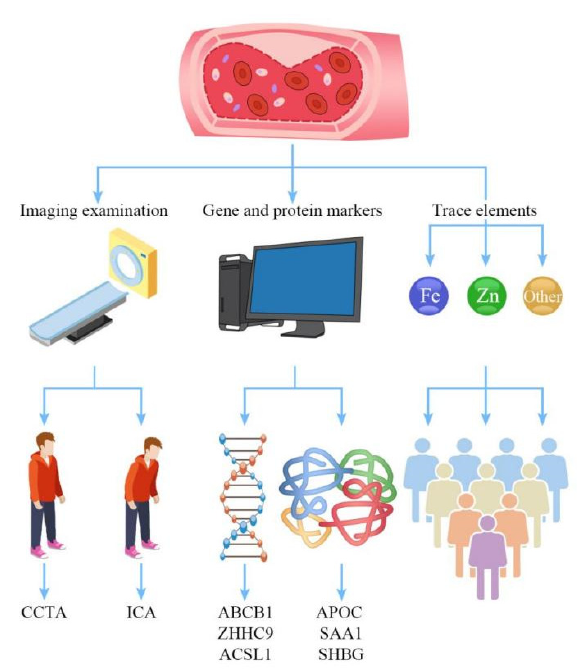
Figure 1. Flow chart of the three examination modes of coronary atherosclerosis. From left to right are imaging examination, gene and protein marker examination, and trace element examination.